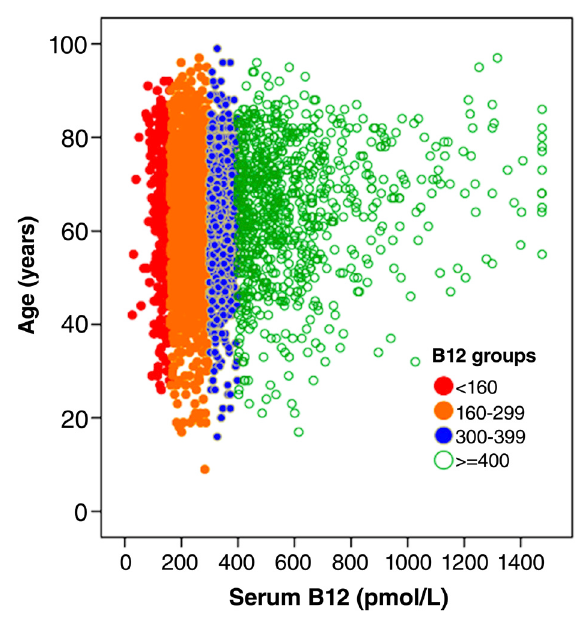
Figure 3. Serum B12 levels among patients attending a stroke prevention clinic. Among 3,025 patients attending a stroke prevention clinic, only 26% had a clearly adequate level of serum B12 >400 pmol/L; of those, many (as seen by the very high levels) were taking B12 supplements. Reproduced by permission of Elsevier from